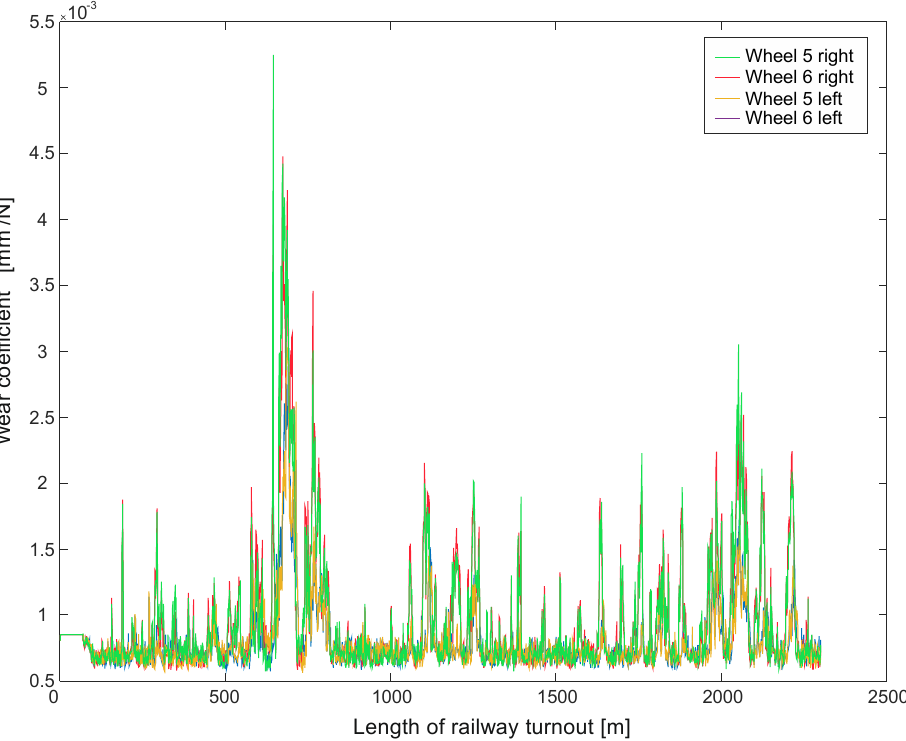
Figure 29. Wear coefficient obtained for a straight track without a turnout at 150 km/h.